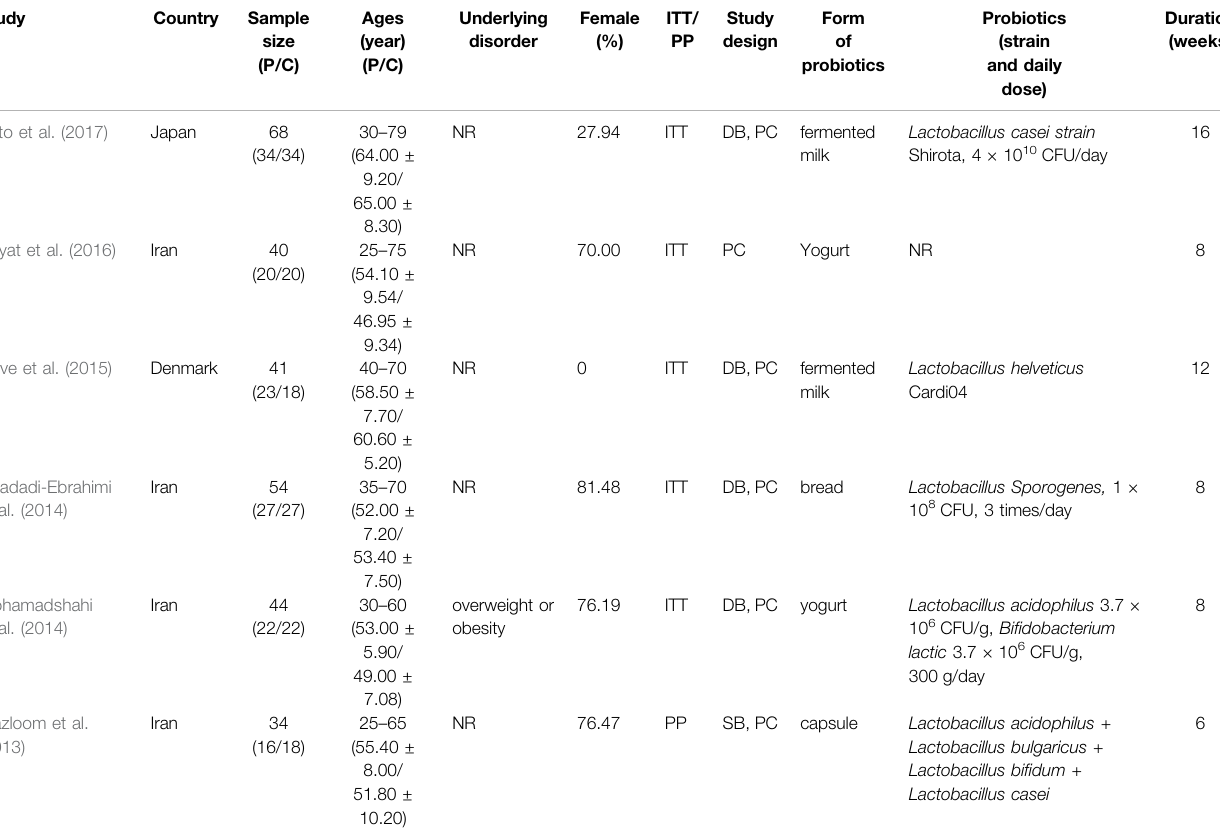
Subgroup analysis ( Table 2 ) strati fi ed by probiotic dosage, the number of probiotic strains, duration of intervention or method of administration showed that the effects of probiotic supplementation on TNF- α were signi fi cantly reduced